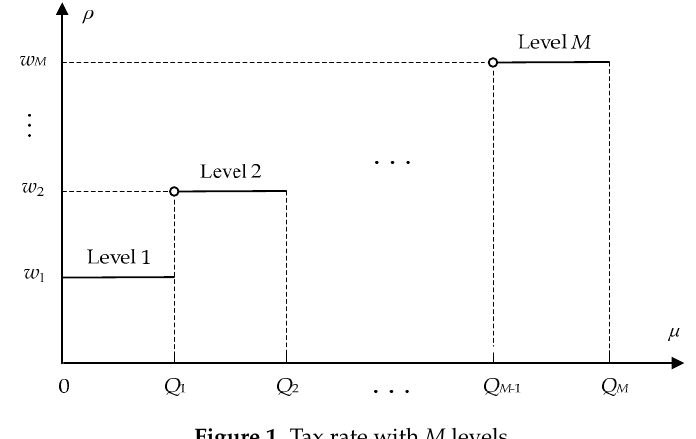
Figure 1. Tax rate with M levels.